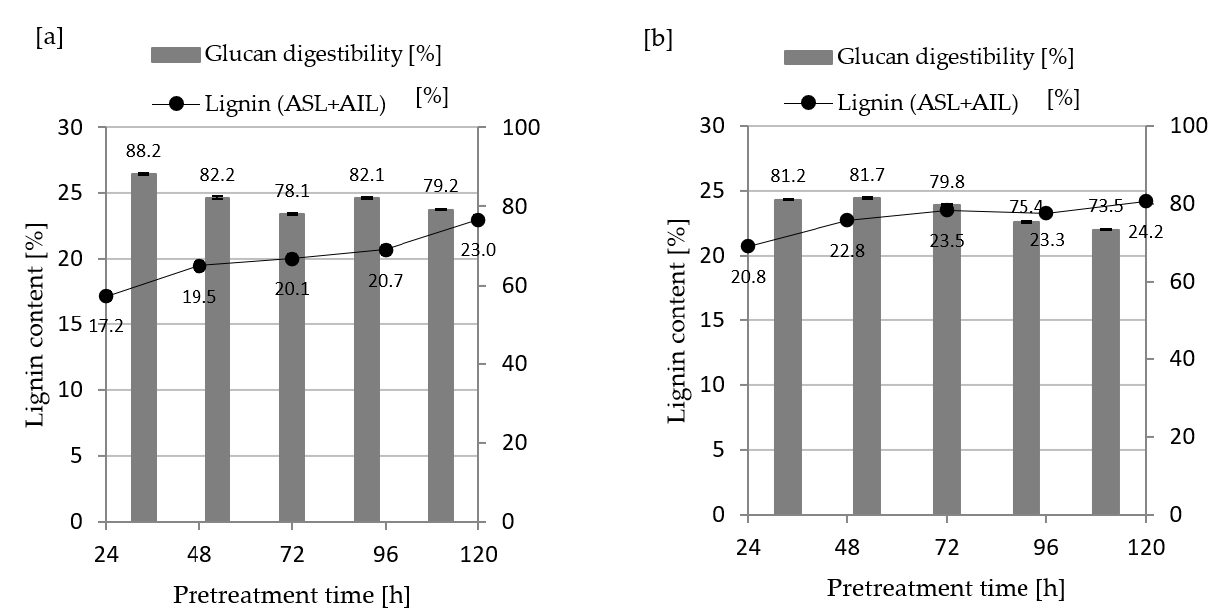
Figure 3. Effect of lignin content on enzymatic digestibility of corn stover. Treatment conditions: ( a ) ELLA treatment: L/S = 1.12, 0.3 g-NH 3 /g-biomass, 150 ◦ C, 24–120 h; and ( b ) ELLA treatment: L/S = 2.5, 0.3 g-NH 3 /g-biomass, 150 ◦ C, 24–120 h. ASL: acid soluble lignin; AIL: acid insoluble lignin. Enzymatic hydrolysis conditions: CTech2; 15 FPU/g-glucan loading; 50 ◦ C, 150 rpm; hydrolysis time, 72 h.